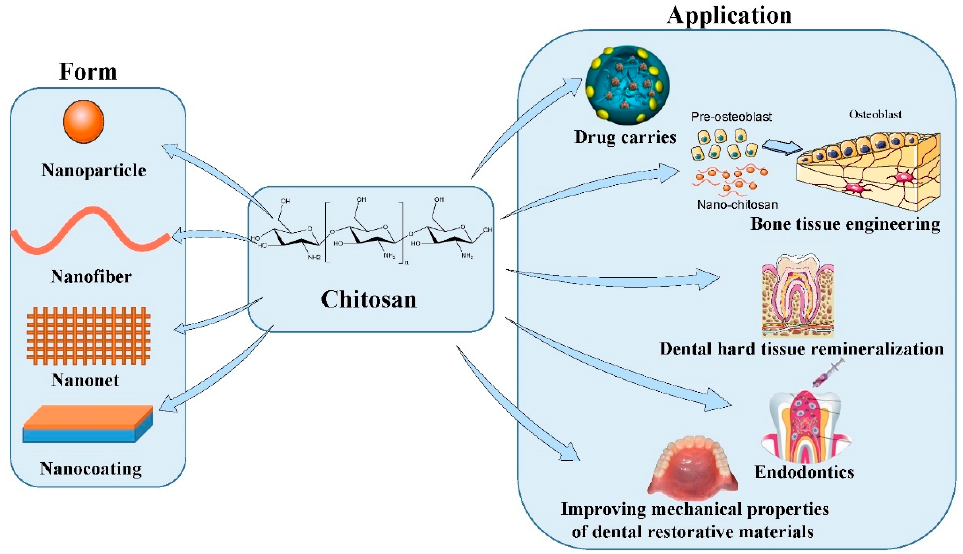
Figure 1. Common forms of nano-chitosan and their application in stomatology (Picture material cited from https://smart.servier.com/ (accessed on 10 September 2021) and [4]).